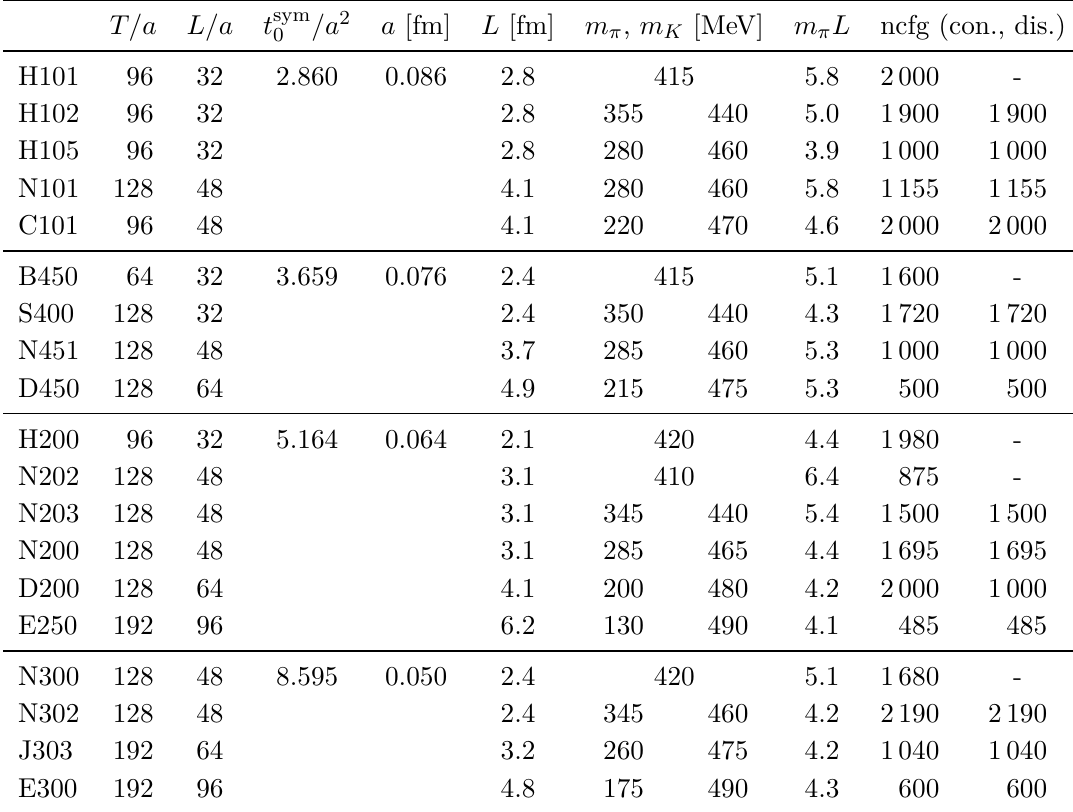
Table 1 . List of CLS ensembles employed in this work, with approximate lattice spacings, spatial volume and pion and kaon masses. All ensembles realize open boundary conditions in time, except for B450, D450 and E250 on which the temporal boundary conditions are periodic. Values of t sym and a are taken from ref. [66]. The number of configurations used for connected and disconnected vector correlator measurements is listed in the last two columns.